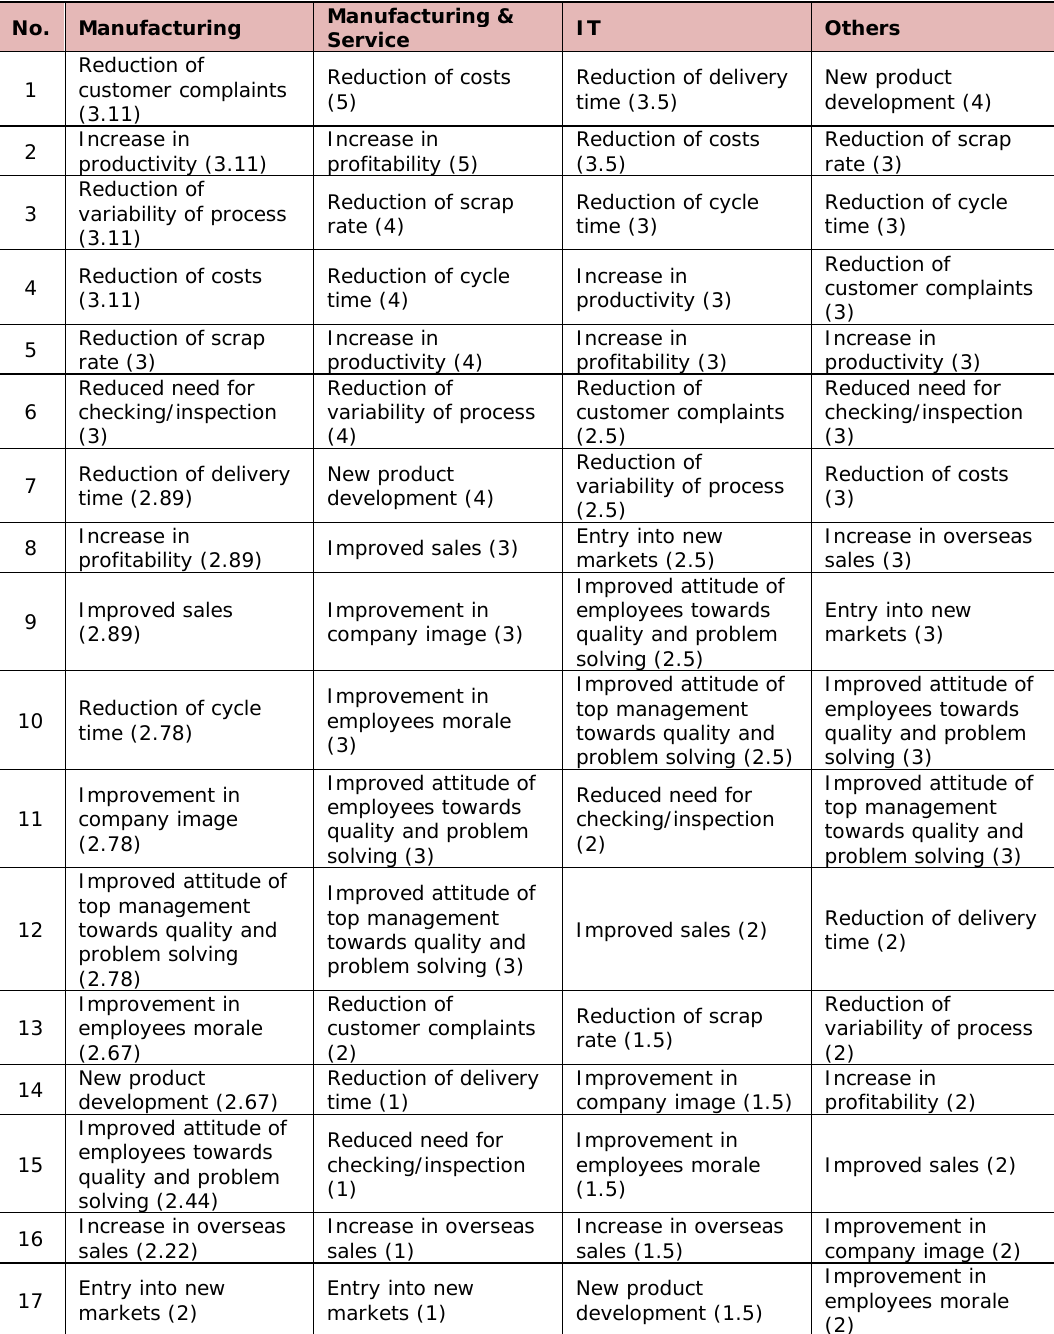
Table 5. “Benefits drawn from Six Sigma implementation in different industrial sectors (in their descending order with mean rating value in the